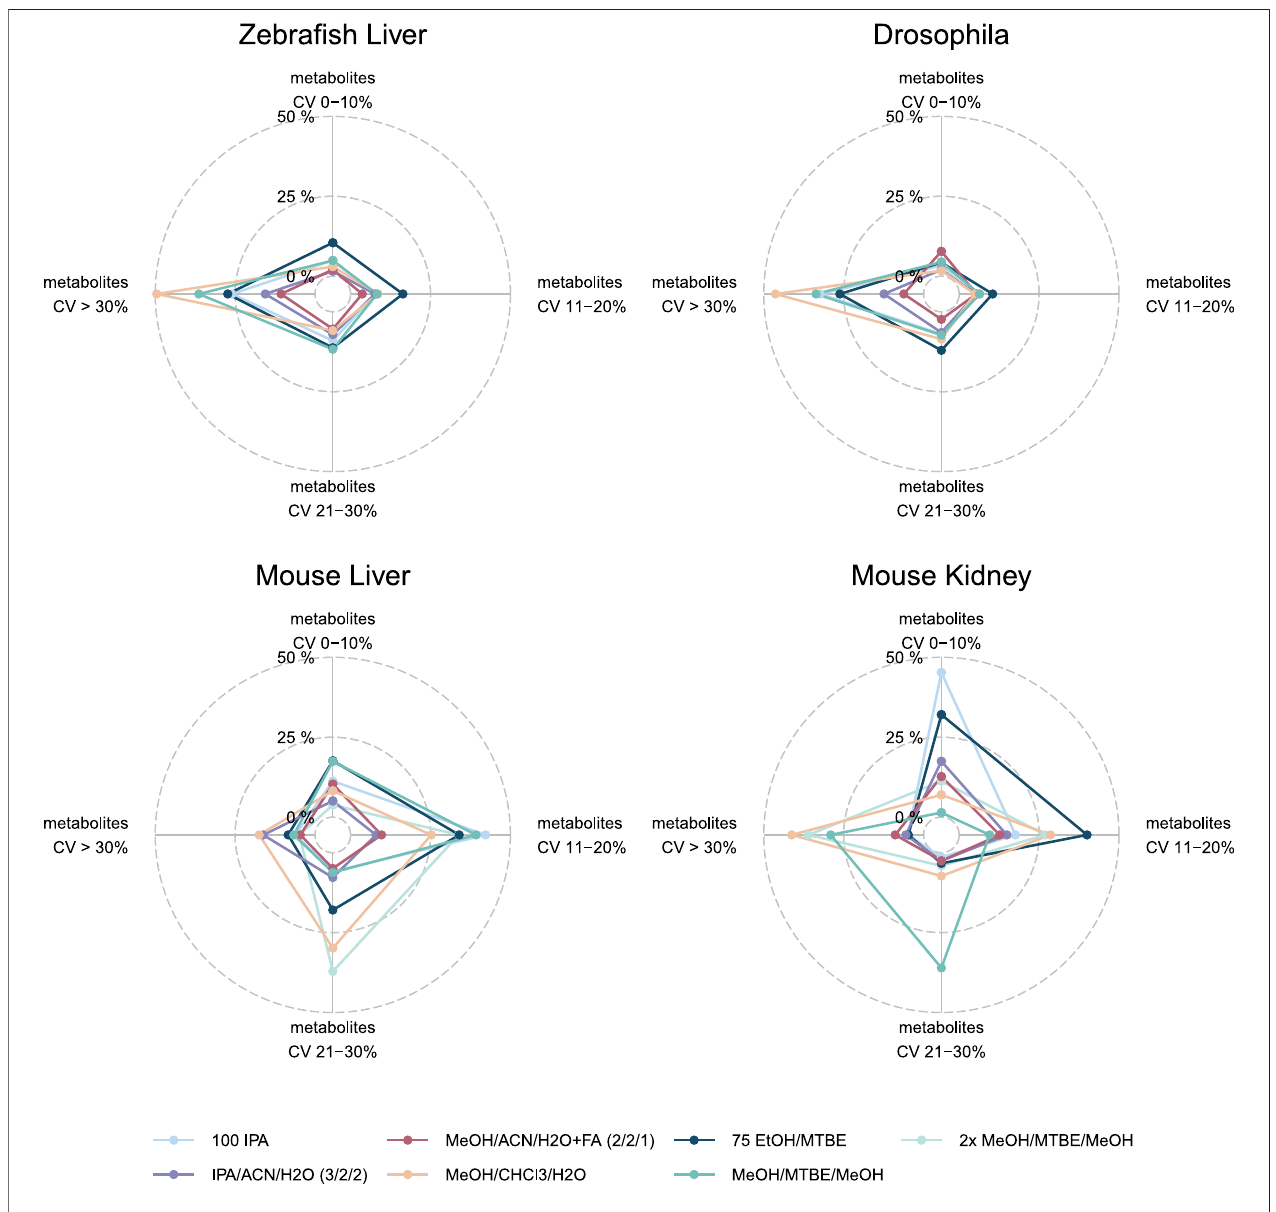
FIGURE4| Variabilityofextractionproceduresacrossallsampletypesandmodelorganisms.Indicatedbycolorarethedifferentextractionprotocolsused.TheCV % was generated based on the triplicate analyses. For each of the CV% categories the percentage of the total 630 metabolites. Note that 2xMeOH/MTBE/MeOH was only used for mice sample types. Alternative visualizations of the CV% and MAD are shown in the ( Supplementary Figure S3, S4 ).